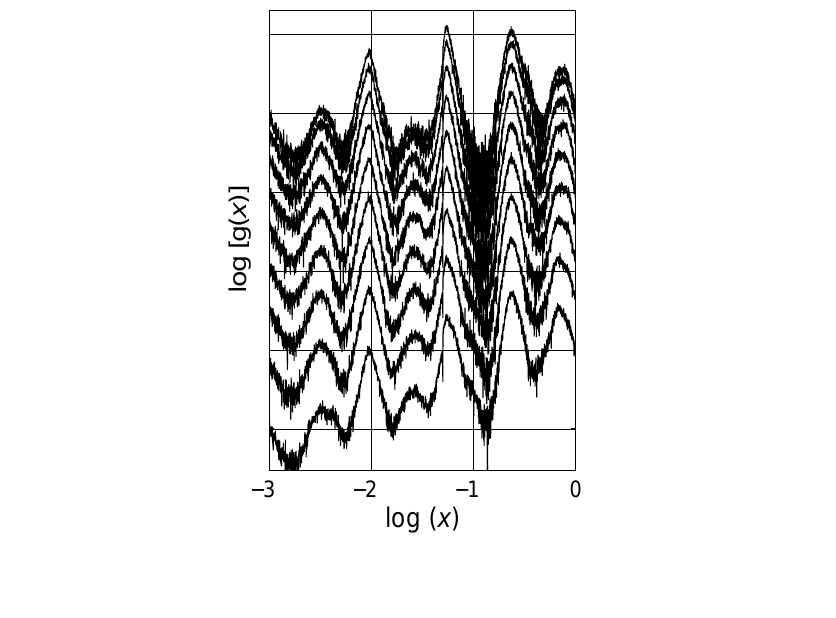
Figure 11 . Spectral density function values at constant x ; log( x ) = − 2 . 5 ( (cid:70) ), log( x ) = − 2 ( • ), log( x ) = − 1 . 275 ( (cid:72) ) and log( x ) = − 0 . 675 ( (cid:4) ). The inset illustrates the ratios for log { g [log( x ) = − 2 . 5] } / log { g [log( x ) = − 2] } ( (cid:3) ), log { g [log( x ) = − 2 . 5] } / log { g [log( x ) = − 1 . 275] } ( (cid:79) ) and log { g [log( x ) = − 2 . 5] } / log { g [log( x ) = − 0 . 675] } ( ◦ ). Logarithmic scale is base